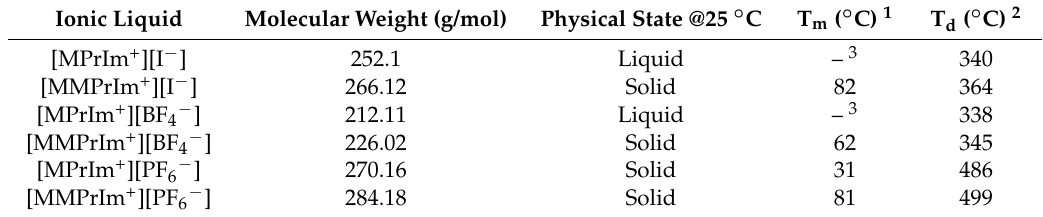
Table 2. Thermal properties of C2-methylated and C2-protonated imidazolium-based ionic